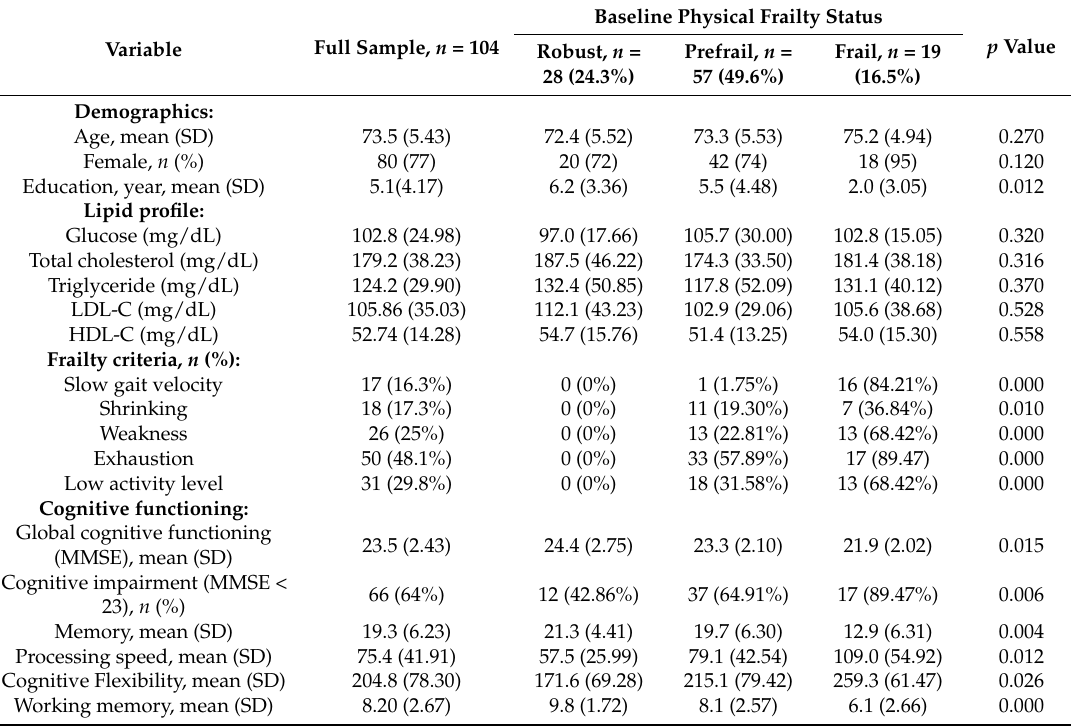
Table 1. Baseline characteristics for full sample and stratified by frailty